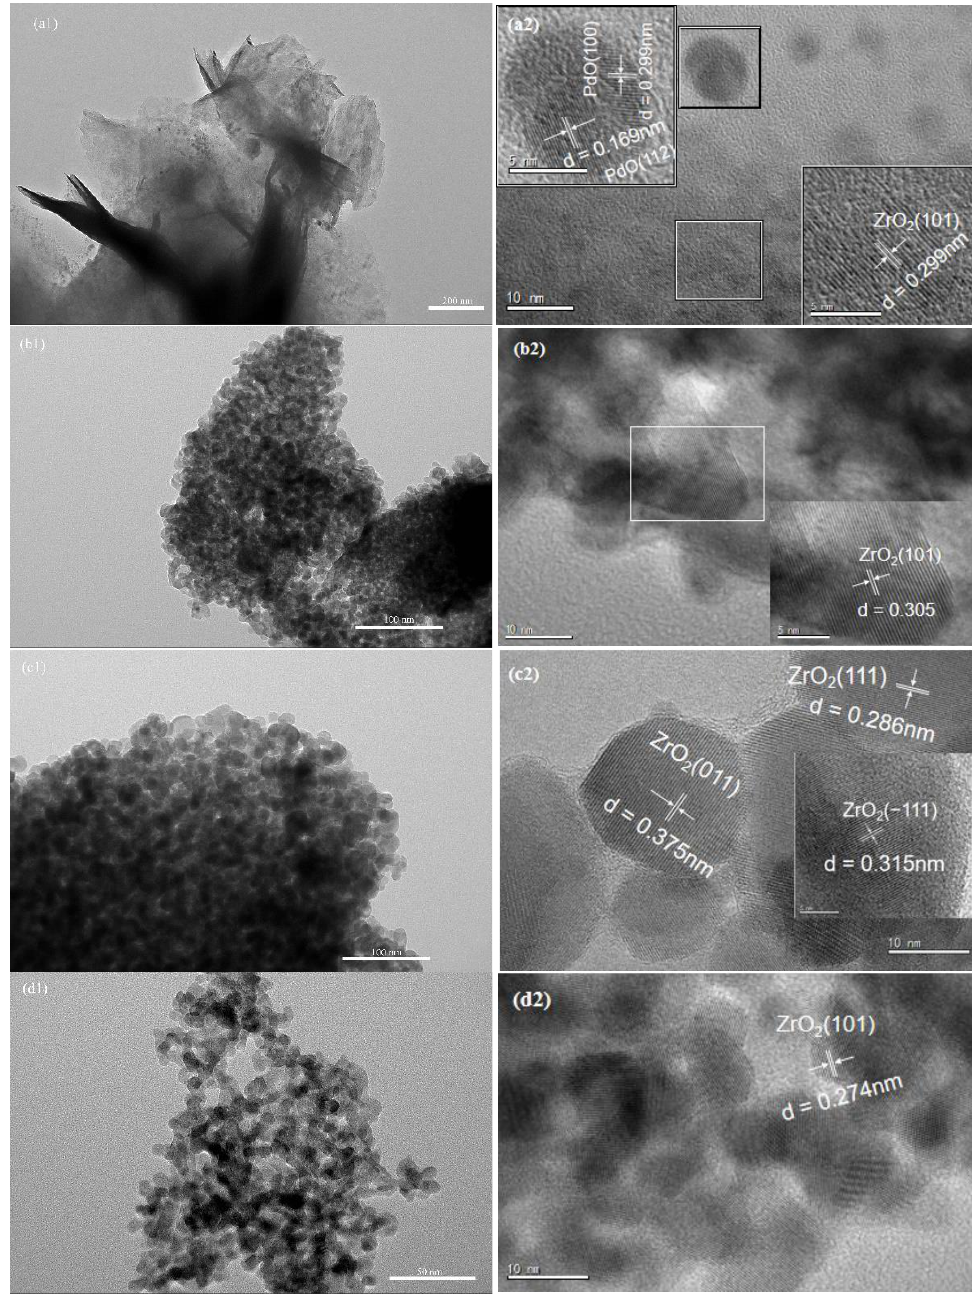
Figure 6. TEM images of Pd / FlYZr ( a1 ), Pd/SpYZr ( b1 ), Pd/ReYZr ( c1 ), Pd/BuYZr ( d1 ) , and HRTEM images for Pd / FlYZr ( a2 ), Pd/SpYZr ( b2 ), Pd/ReYZr ( c2 ), Pd/BuYZr ( d2 ). HRTEM images for Pd/FlYZr ( a2 ), Pd/SpYZr ( b2 ), Pd/ReYZr ( c2 ), Pd/BuYZr ( d2